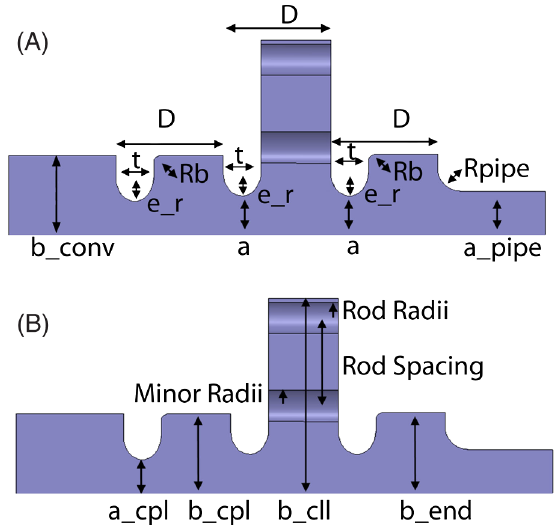
FIG. 4. Normalized electric field profile on axis in PBG-E structure; the field amplitude in each coupling cell is approxi- mately half that in the PBG